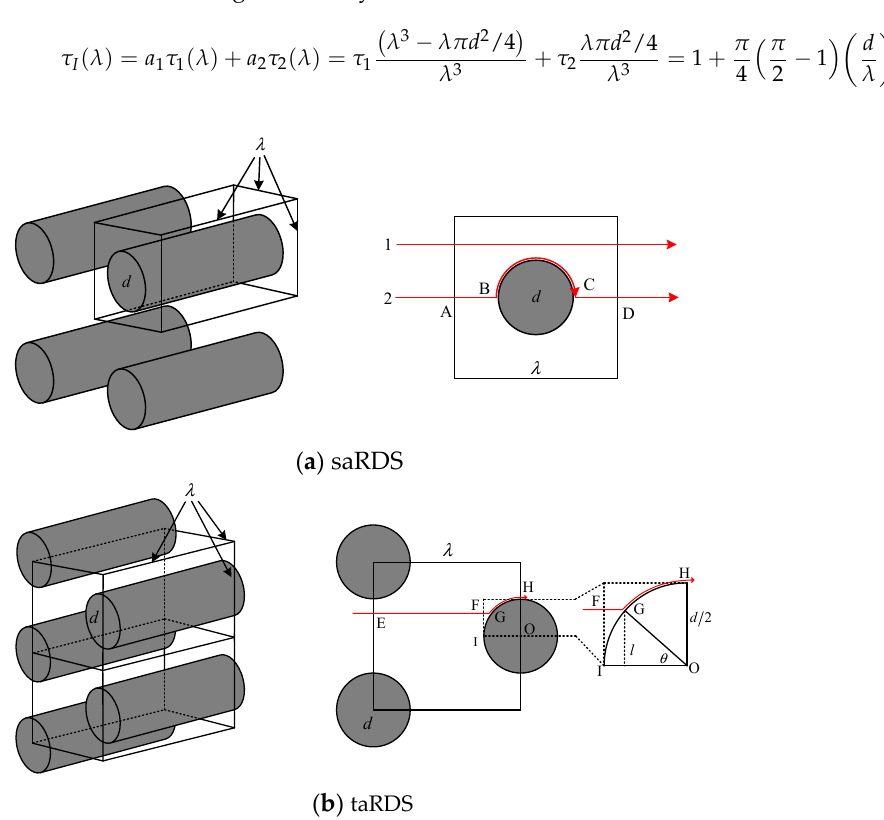
Figure 2. The representative distribution structures of fiber columns: ( a ) square arrangement; ( b ) triangular arrangement.